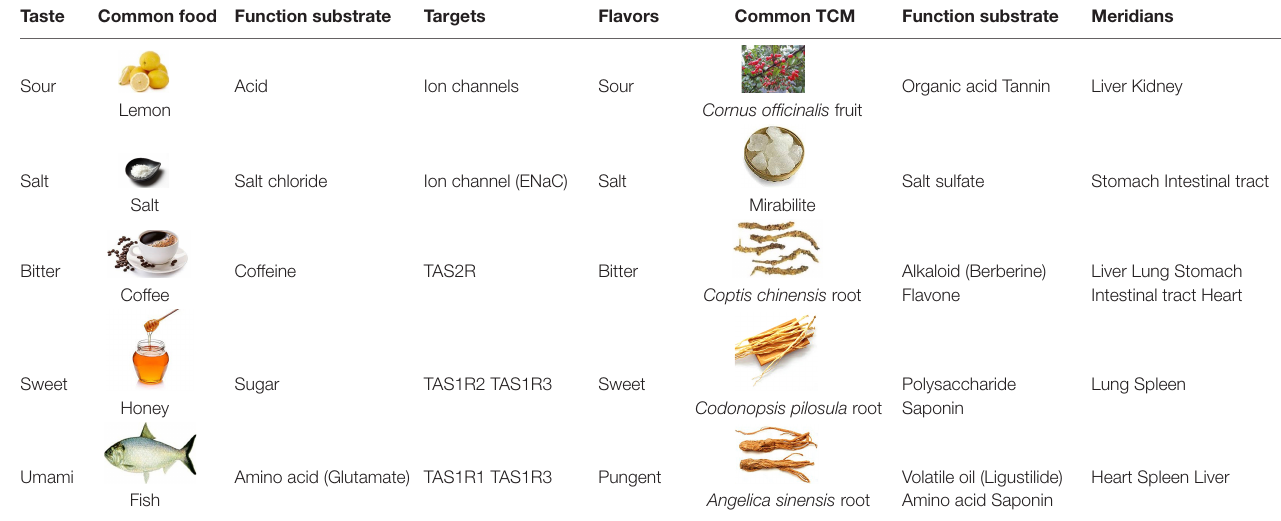
TABLE 1 | Comparison of five tastes in gustatory perception and five flavors in